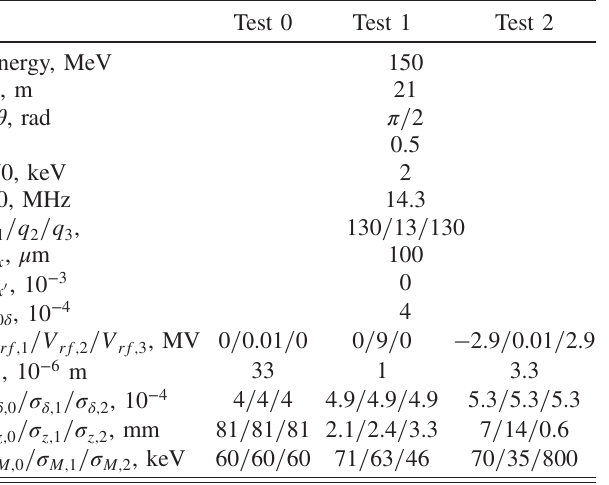
TABLE II. Parameters of the toy ring with longitudinal mono-